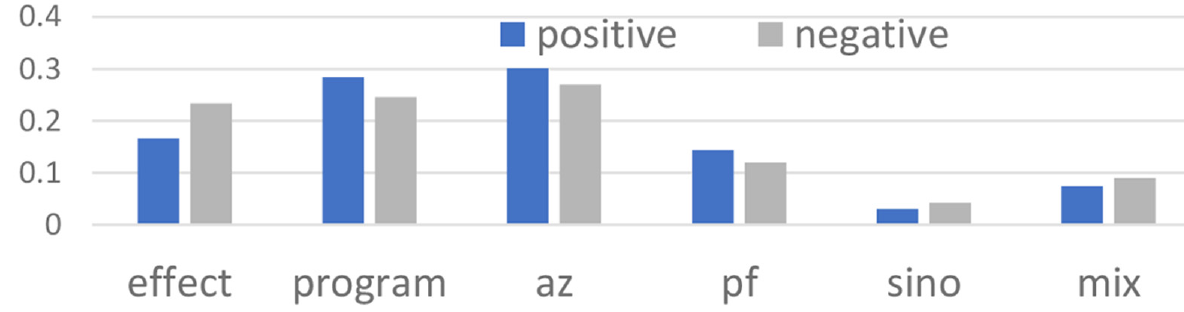
Figure 5. Topic sentiments’ probabilities.